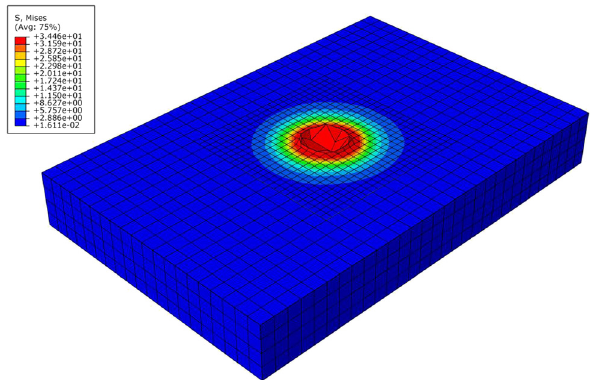
Figure 14: Stress contour of specimen F70MC0.6M - I.